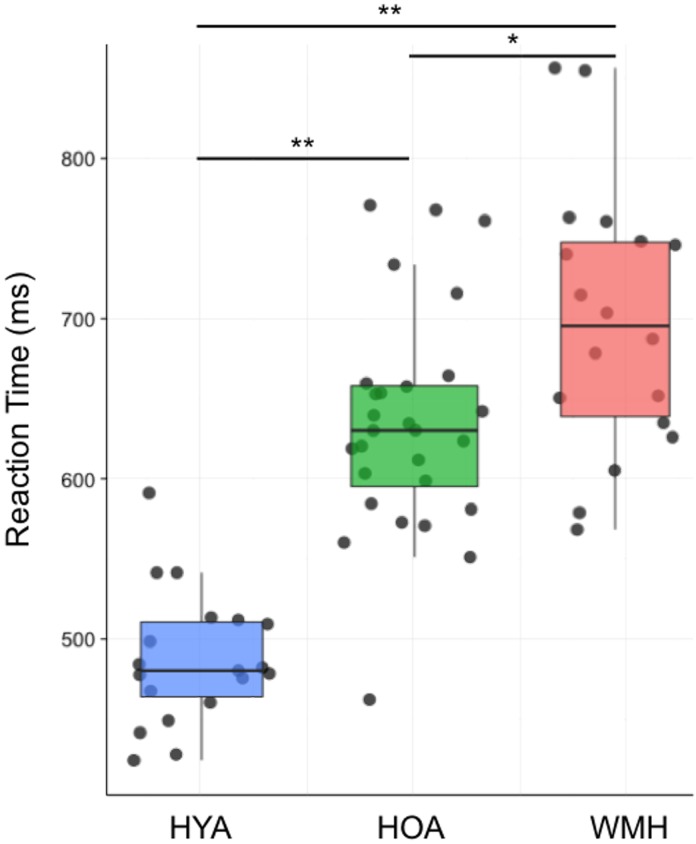
Average reaction time group differences across all trials of the fMRI attention network task. Average reaction time during both congruent and incongruent conditions indicate WMH had reduced performance compared to both HOA and HYA, and HYA performed better than HOA. ∗ < 0.01 and ∗∗ < 0.001.